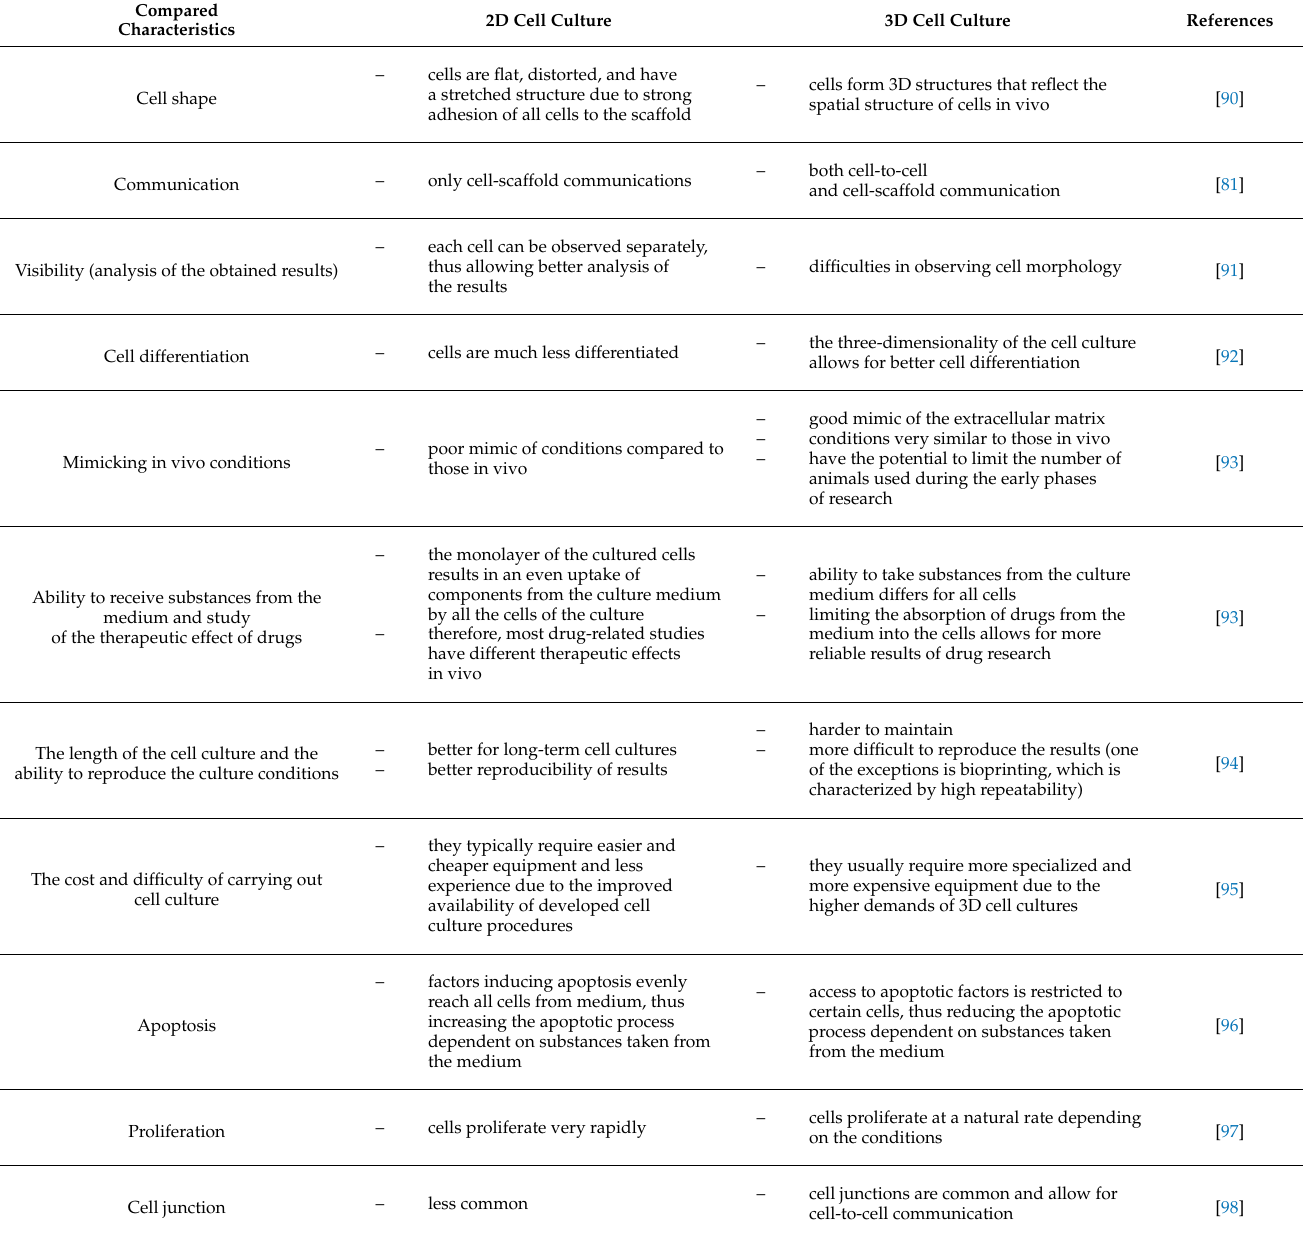
Table 9. Effects of cell culture dimensionality on cell